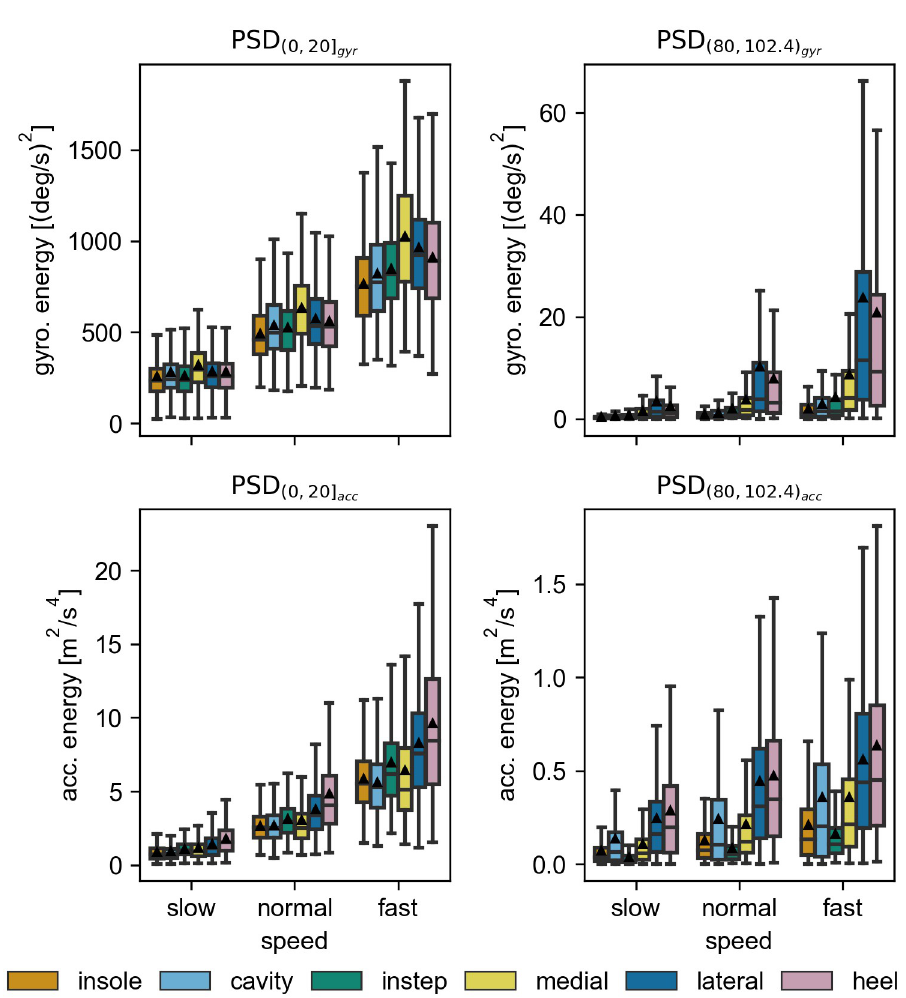
Fig 10. The average power spectral density for the high and low frequency bins. The average spectral power of the accelerometer (bottom row) and the gyroscope norm (top row) in the frequency ranges 020 Hz (left column) and 80102.4 Hz (right column). Each datapoint used in the boxplots corresponds to a single stride. The black triangles mark the means of the distributions. All outliers ( > Q 3 + 1.5 IQR ) are removed from the